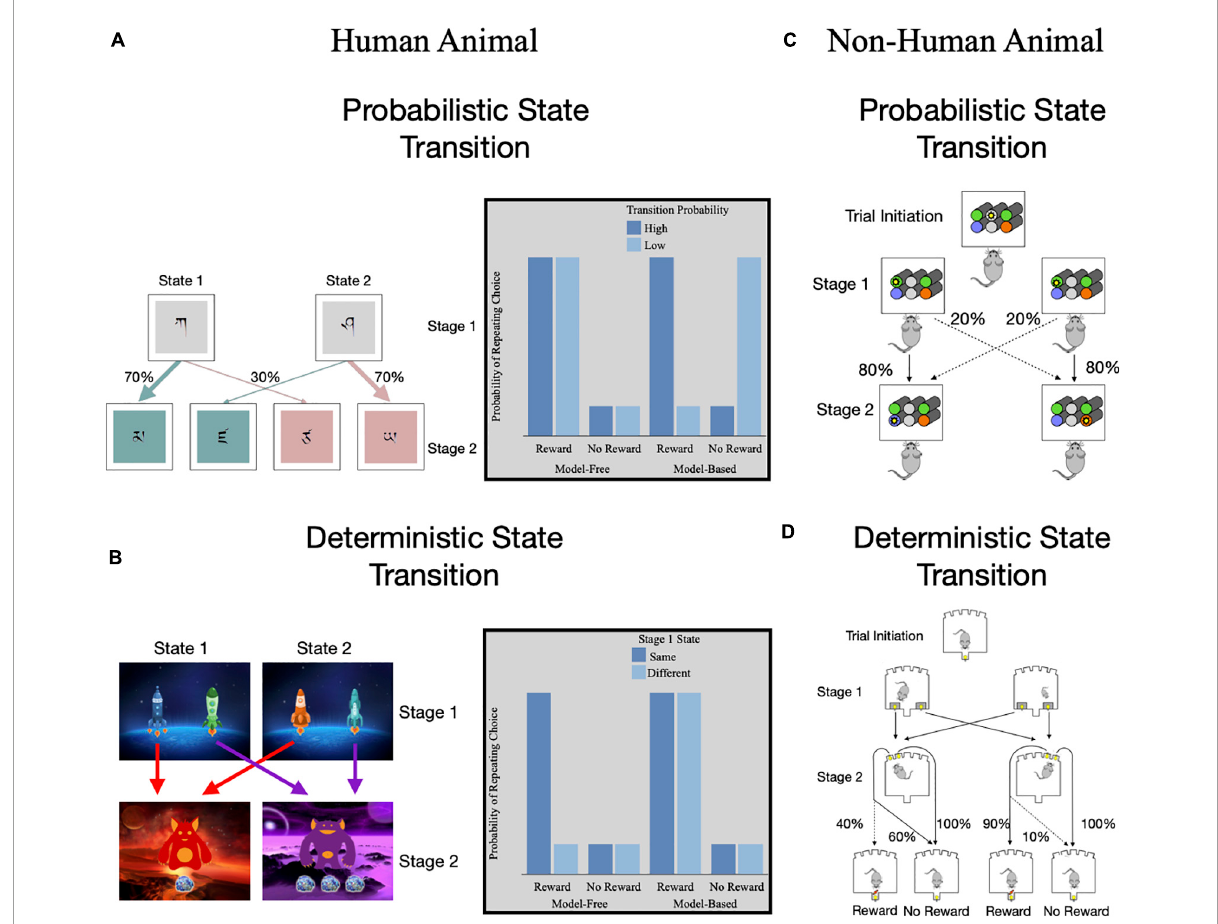
FIGURE3 Methods of assessing model-based and model-free reinforcement learning using two-step serial decision-making tasks. Two-step tasks have two stages of decisions with the second stage state dependent upon the first stage choice. (A) Daw et al.’s (68) task that uses a probabilistic transition from stage 1 to 2. Gray box highlights the theoretically expected probability of repeating a stage 1 choice for model-free and model-based learning based on previous trial reward and transition probability. (B) Kool et al.’s (82) task that uses a deterministic transition from stage 1 to 2. Gray box highlights the theoretically expected probability of repeating a stage 1 choice for model-free and model-based learning based on previous trial reward and whether the current trial stage 1 state differs from the previous trial’s stage 1 state. (C) Miller et al.’s (80) translation of a two-stage task for non-human animals with probabilistic state transitions. (D) Groman et al.’s (87) translation of a two-stage task for non-human animals with deterministic state